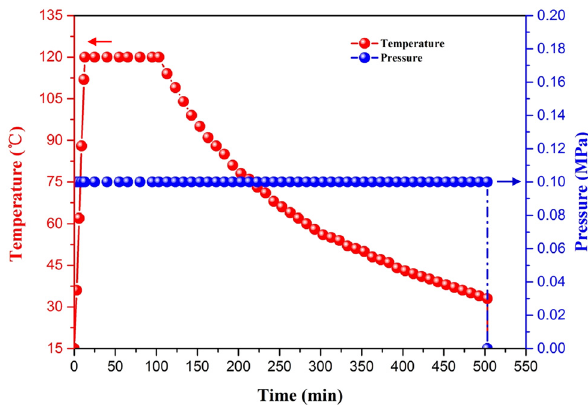
Figure 2: Curing condition of the composites.